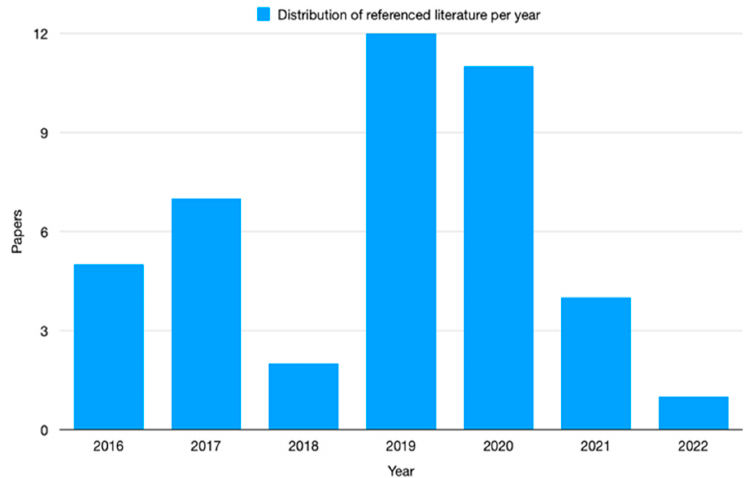
Figure 1. Distribution of referenced literature per year.